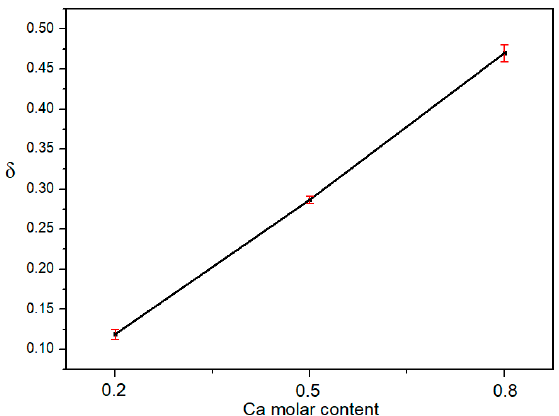
Figure 4. The Oxygen non-stoichiometry of La 1 − x Ca x Co 0.5 Fe 0.5 O 3 − δ (x = 0.2, 0.5, 0.8).